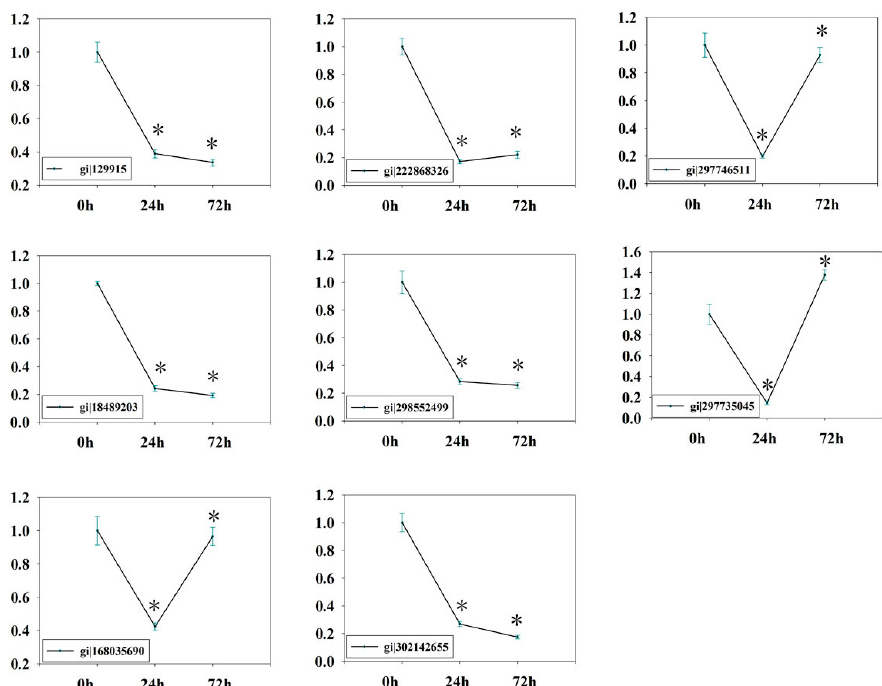
Figure 9. qPCR data for the mRNA expression levels of genes for drought-responsive proteins mapped in glycolytic/gluconeogenetic pathway in ramie leaves. The values represent relative mRNA levels against control groups (0 h samples), values of which were all set to 1 unit. Statistically significant differences in gene expression are indicated with asterisks: * p < 0.05.